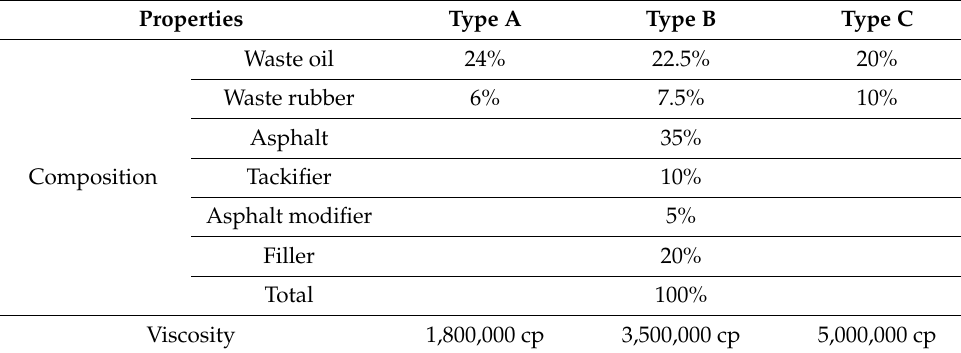
Table 2. Composition and viscosity of SPRG.